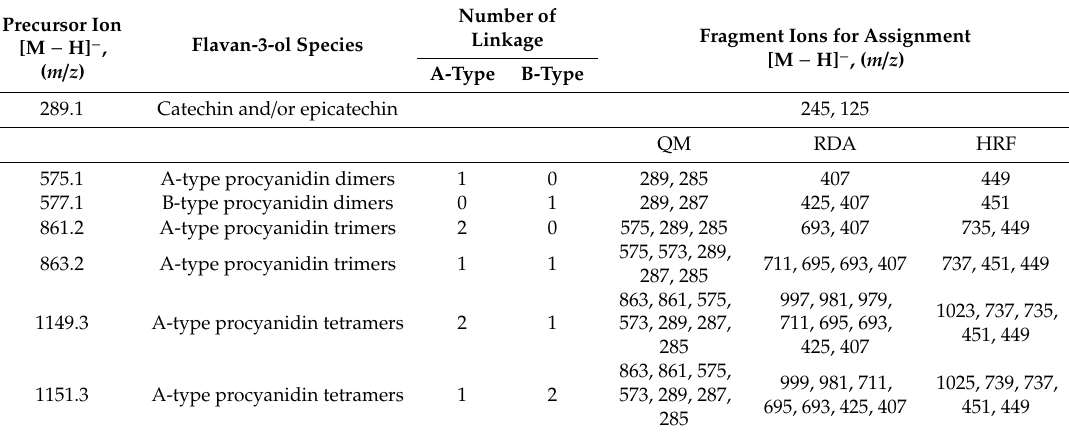
Figure 5. Typical fragmentation pattern of ( A ) A-type and ( B ) B-type procyanidin dimers. The characteristic fragmentation mechanisms by negative-ion mode are retro-Diels-Alder (RDA), heterocyclic ring fission (HRF), and quinone methide (QM) reactions. Table 1. Assigned flavan-3-ol species in peanut testa.